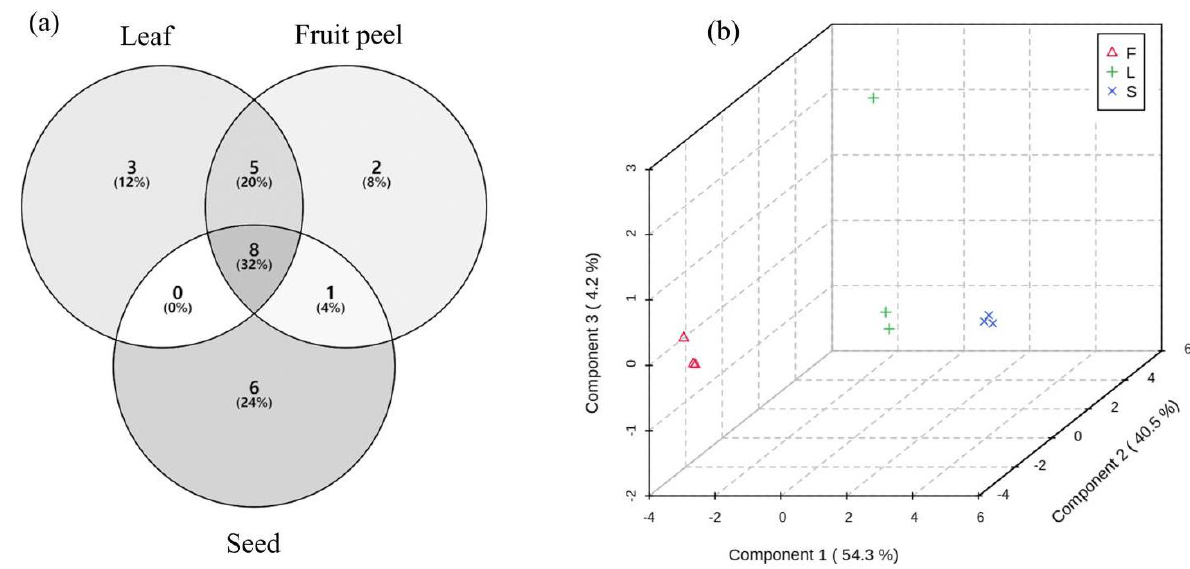
Figure 2. Venn diagram of volatile numbers in different plant tissues ( a ) and 3D score plots between the selected components ( b ). Letters F, L, and S in the legend of subpart ( b ) stand for fruit peel, leaves, and seeds, respectively. Table 1. Volatile chemicals and their relative proportions as emissions from Camellia oleifera leaves, fruit peels, and seeds (N =